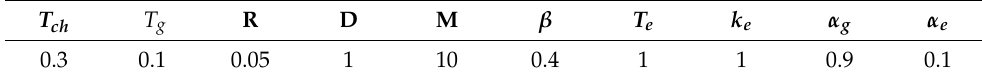
Table 2. Power Systems Parameters for LFC